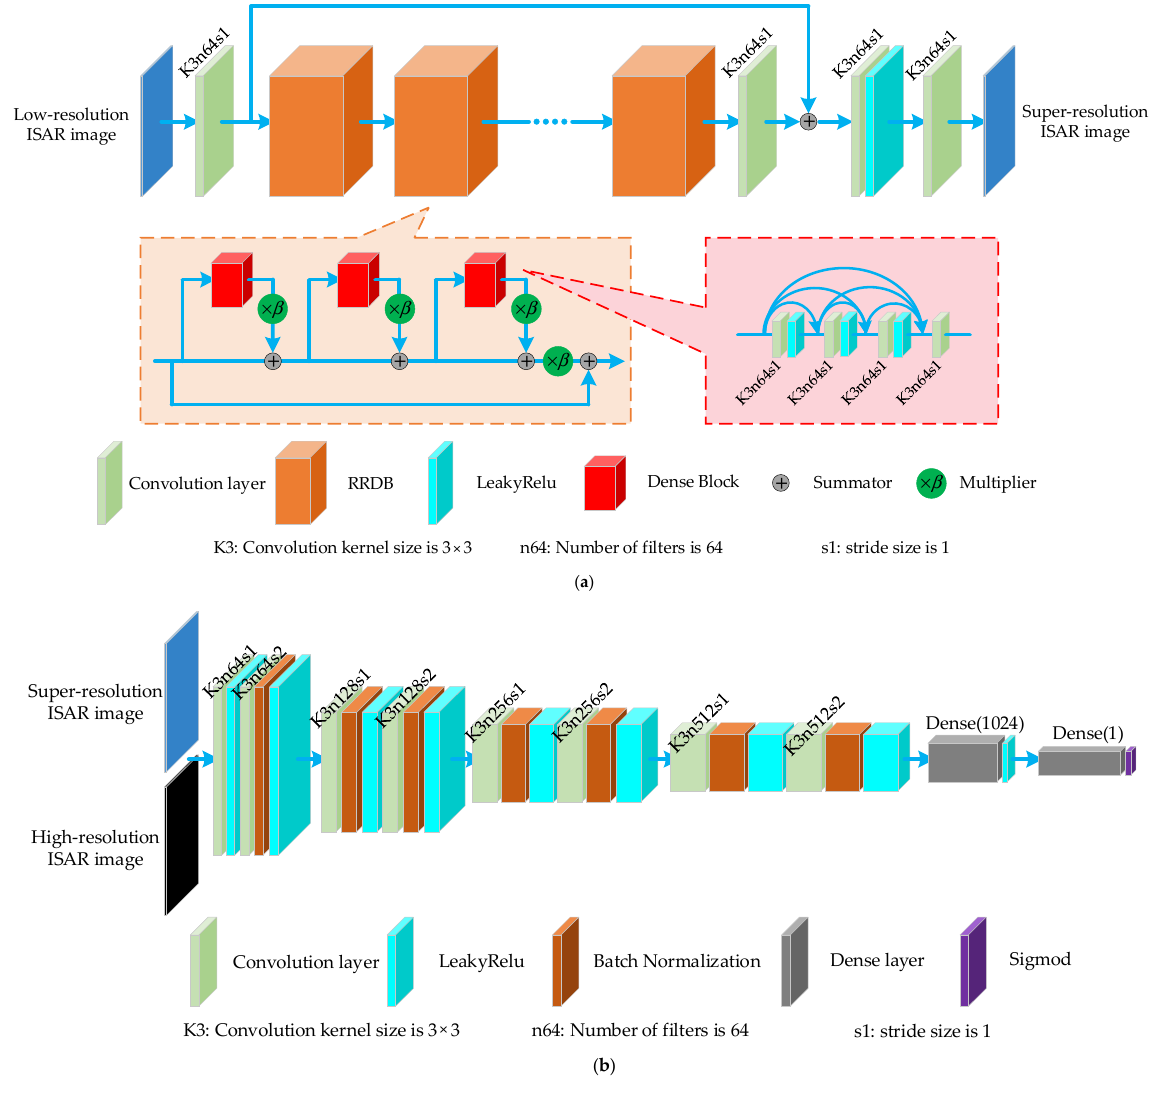
Figure 3. The architecture of the proposed GAN for ISAR resolution enhancement: ( a ) the structure diagram of generator network; ( b ) the structure diagram of discriminator network. diagram of generator network; ( b ) the structure diagram of discriminator